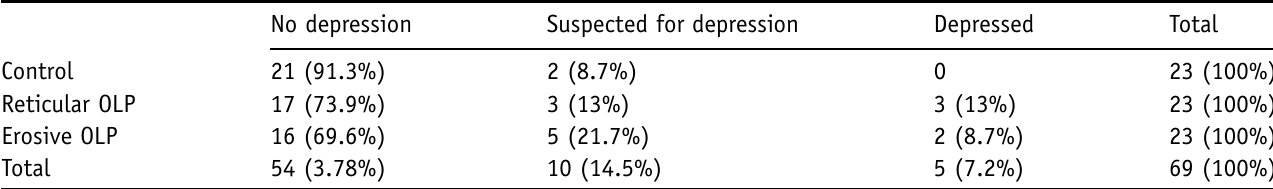
Table VI. Frequency of different levels of depression in the three